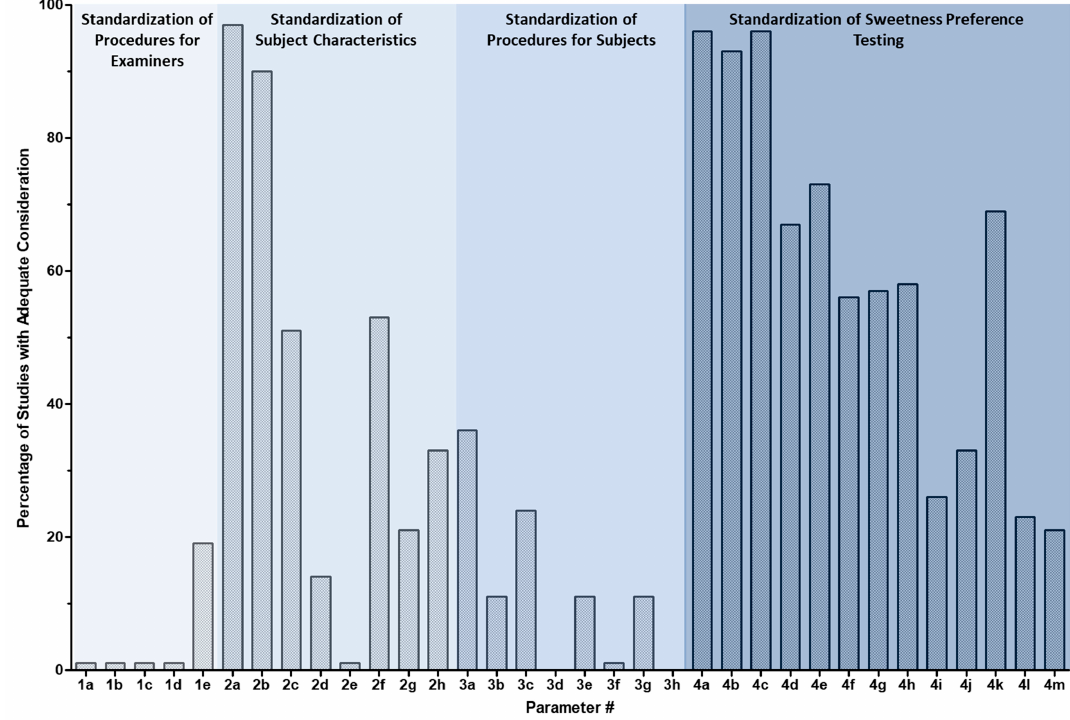
Figure 5. Summary of the scoring parameters from the “investigator checklist”. The percentage of studies in which adequate consideration of the identified parameter in the investigator checklist is provided. The “investigator checklist” is available in Table S2-1 of Supplementary File S2; an abbreviated version of the checklist is available in Table